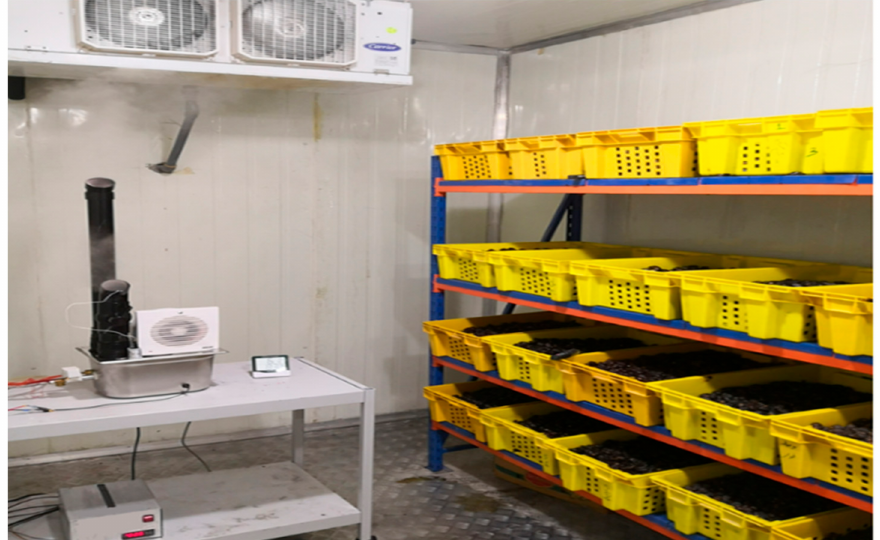
Figure 5. The experimental setup in the controlled cold storage room showing the designed humidi- fier and crates of stored